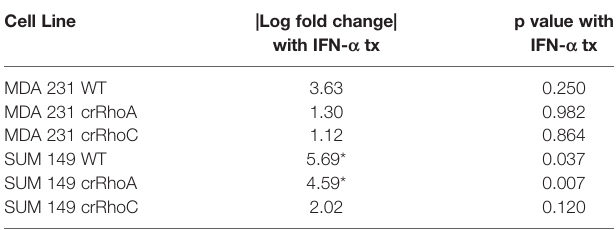
TABLE 1 | RhoC knockout dampens IFN- a -driven increase in cell-cell adhesion. Cell Line |Log fold change| with IFN- a